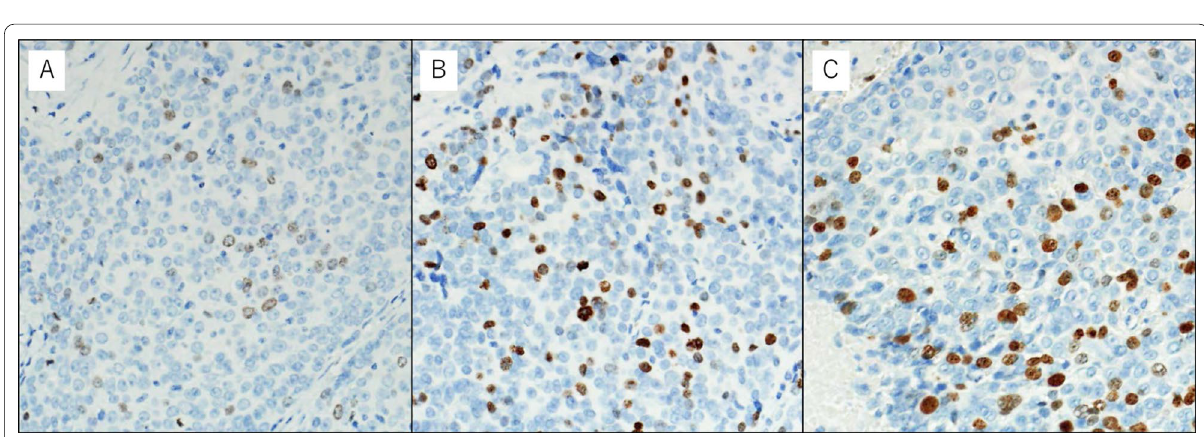
Fig. 3 Immunohistochemical staining of the primary tumor and disseminated nodules for Ki-67. The fraction of Ki-67-positive tumor cells in the primary tumor ( A ), disseminated nodule at the third postoperative year ( B ), and that at the 16th postoperative year ( C ) were 10%, 15%, and 25%, respectively. Original magnification ×